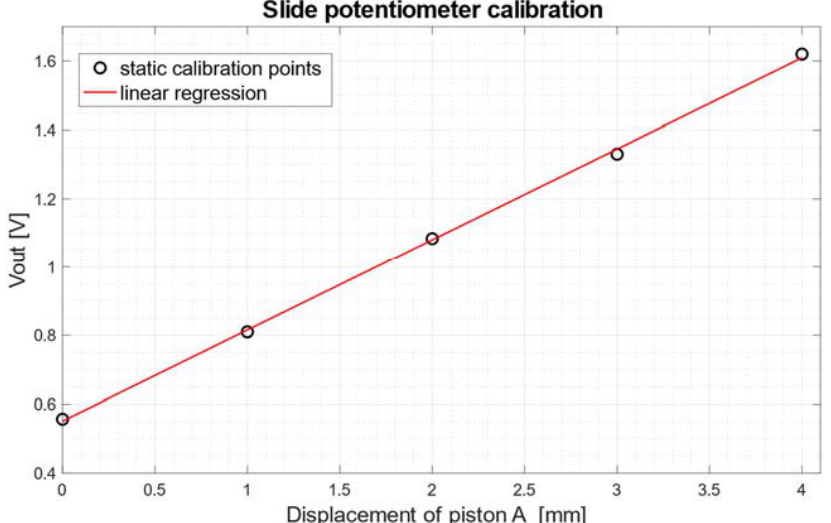
Figure 8. Static calibration of the slide potentiometer: scatter plot of the experimental data (circles) and linear regression (continuous red line).